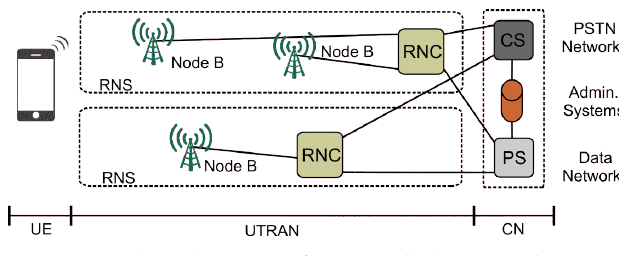
Figure A2. The architecture of UMTS cellular